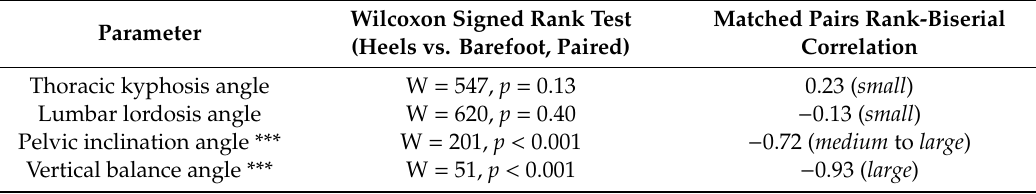
Table 3. Wilcoxon signed rank test results and e ff ect